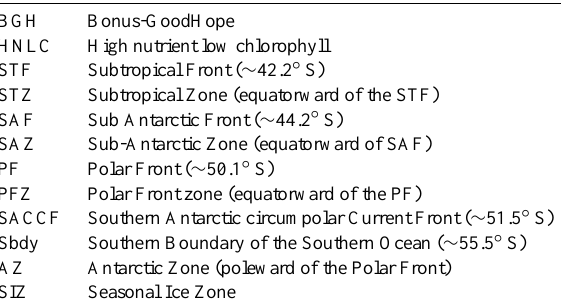
Table 1. List of abbreviations.